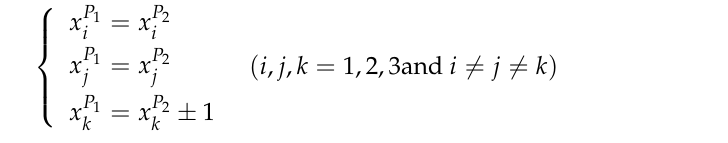
Figure 6. Definition of the RVE.